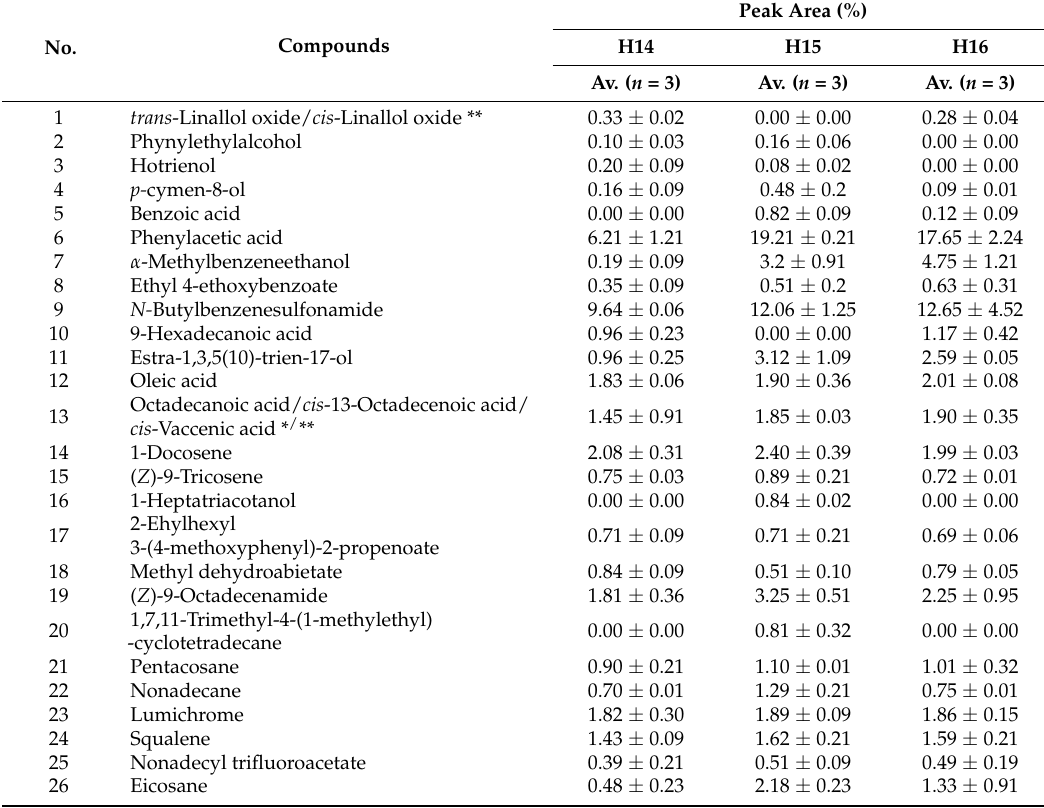
Table 2. Volatile compounds identified by GC-MS in extracts obtained using solid phase extraction (SPE).